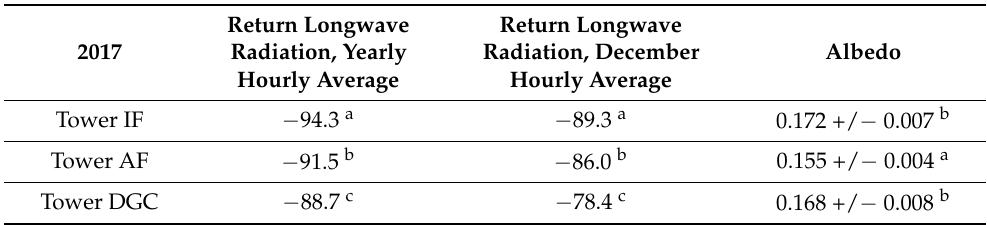
Table 3. Longwave radiation (watts/m 2 , yearly hourly average and December hourly average in 2017) along with mid-afternoon albedo’s estimated in July 2017. Significance based on Kruskal-Wallis one-way ANOVA on ranks ( p < 0.001). Values with different letters indicate significant differences at p <